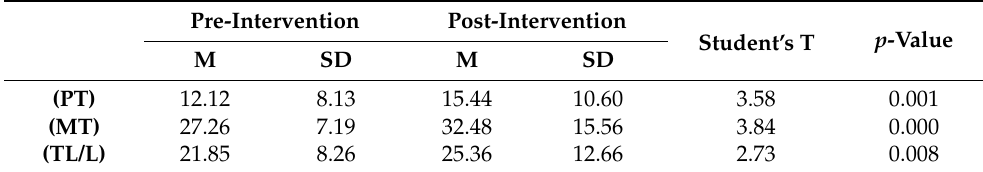
Table 2. Values and comparison of the degrees of each type of curve, before and after performing brace intervention (Mean = 2.07 years, SD =